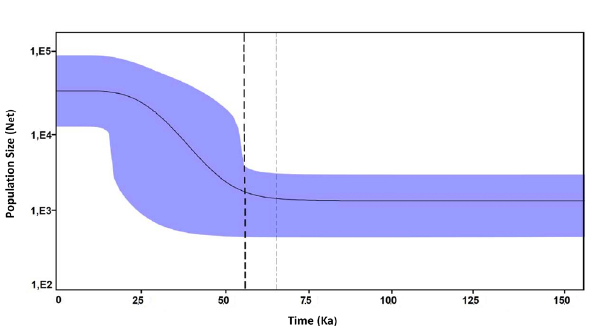
Figure 3. Median-joining haplotype network. Each haplotype is represented by a colored circle indicating the main area where it was collected; the size of the circle is proportional to its frequency in the overall sampling effort.